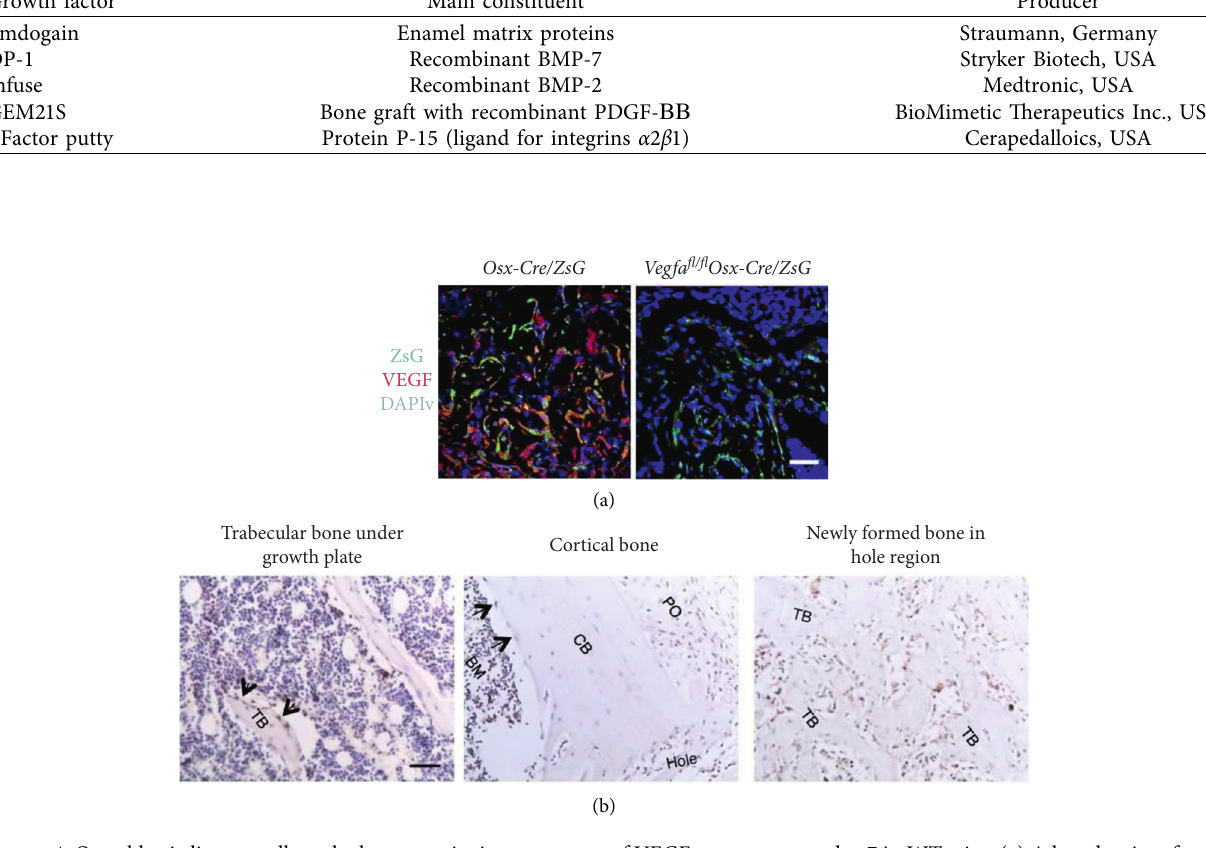
Figure 4: Osteoblastic lineage cells at the bone-repair site as a source of VEGF at postsurgery day 7 in WTmice. (a) A low density of anti- VEGF staining (red) in Vegfa fl/fl Osx-Cre/ZsG mice (6.1%) compared with Osx-Cre/ZsG mice (15.5%). (b) VEGF in cortical bone, trabecular bone, and the newly formed bone within cortical defects. Black arrows show the VEGF-expressing osteoblast lining. TB � trabecular bone and CB � endosteum of cortical bone